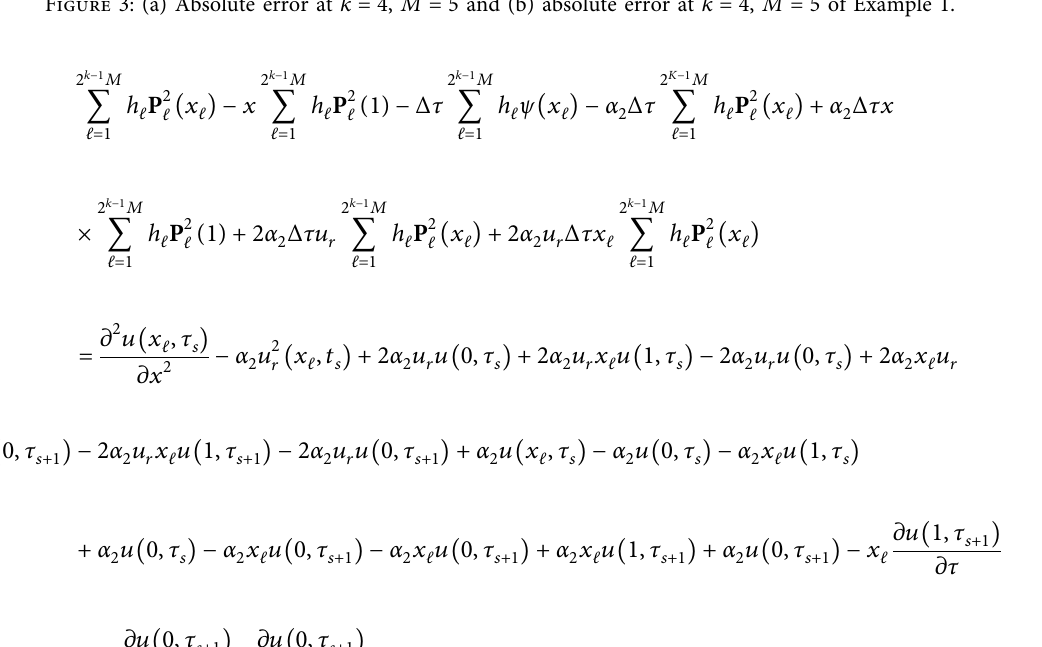
Figure 3: (a) Absolute error at k � 4, M � 5 and (b) absolute error at k � 4, M � 5 of Example